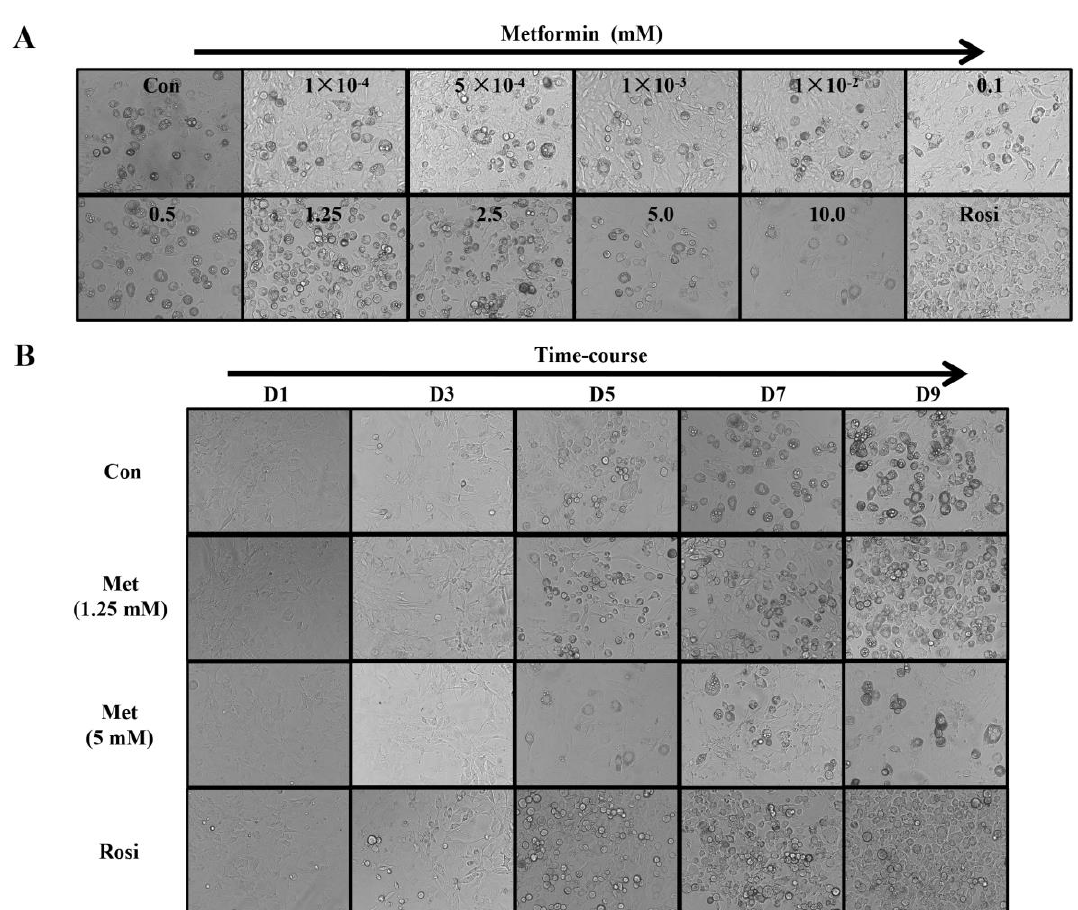
Figure 1. Effects of metformin at various concentrations on 3T3-L1 preadipocytes differentiation. ( A ) Effects of metformin (Met) on adipogenesis in a dose-dependent manner. The 3T3-L1 preadipocytes were treated with a differentiation cocktail and various doses of metformin for 9 days as observed by a microscope, 200 × ; ( B ) Time course of low or high concentrations of metformin (1.25 or 5 mM) on adipogenesis at day 1 (D1), 3 (D3), 5 (D5), 7 (D7), and 9 (D9) as observed by a microscope, 200 × . Control cells were treated with differentiation medium I (DMI) only. Rosiglitazone (Rosi, 2.5 µ M) was used as positive